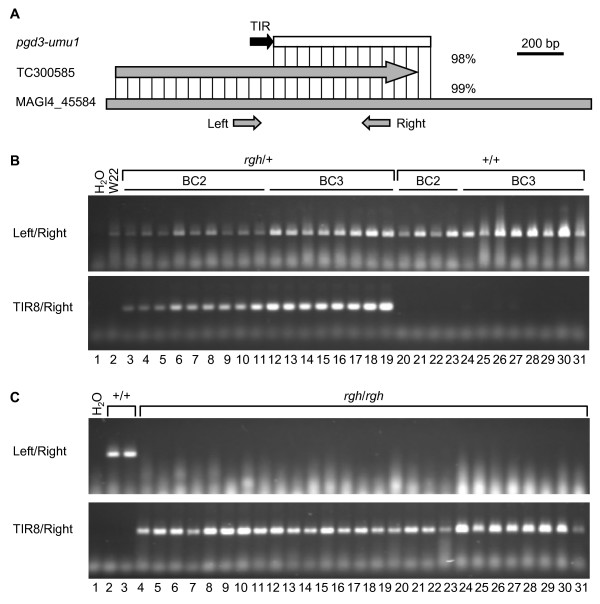
Co-segregation of pgd3-umu1 with rgh*-00S-005-14. (A) Schematic alignment of the bc199 UniformMu FST site (pgd3-umu1), the TC300585 Zea mays Gene Index EST contig, and the maize assembled genomic island, MAGI4_45584. The schematic shows the location of the MuTIR sequence (black arrow, not drawn to scale) and percent nucleotide identity is noted. The left and right primer sites are marked by gray arrows; primer sizes are not drawn to scale. (B) Co-segregation analysis with progeny from backcross generations 2 and 3 (BC2 and BC3) in a W22 introgression. Left/Right products amplify normal alleles. TIR8/Right products amplify the insertion site. (C) Co-segregation analysis with self progeny. PCR was completed with DNA extracted from homozygous normal (lanes 2–3) or rgh mutants kernels (lanes 4–31).